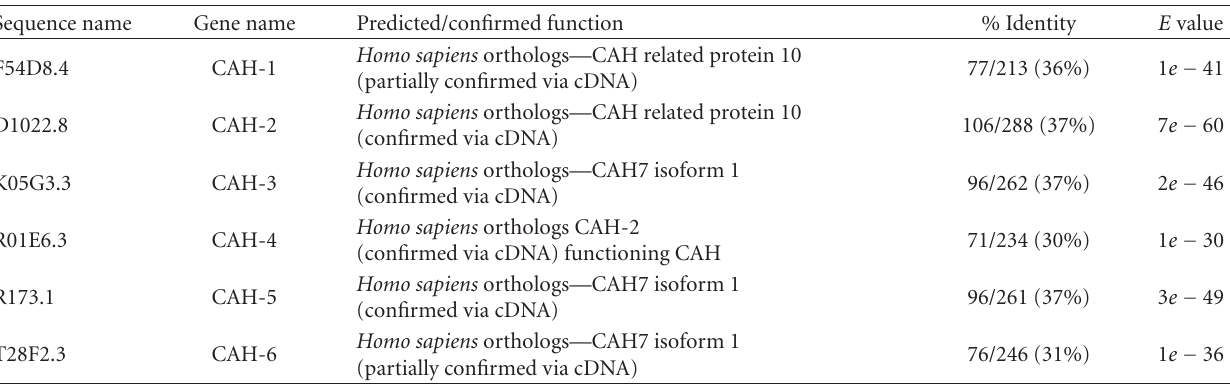
Figure 5: Phylogenetic tree analysis of aspartate aminotransferase (AAT/ASAT/AspAT/GOT (glutamic oxaloacetic transaminase)). See Figure 2 for details on the phylogenetic analysis. Table 2: A-CAH C. elegans